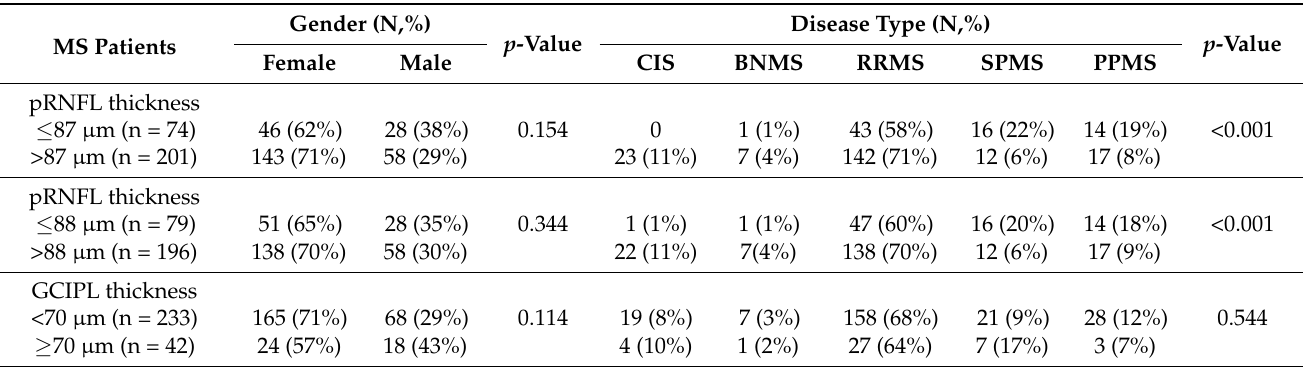
Table 2. Characteristics of the study cohort by cut-off values of pRNFL and GCIPL thickness (discrete variables) (n = 275).